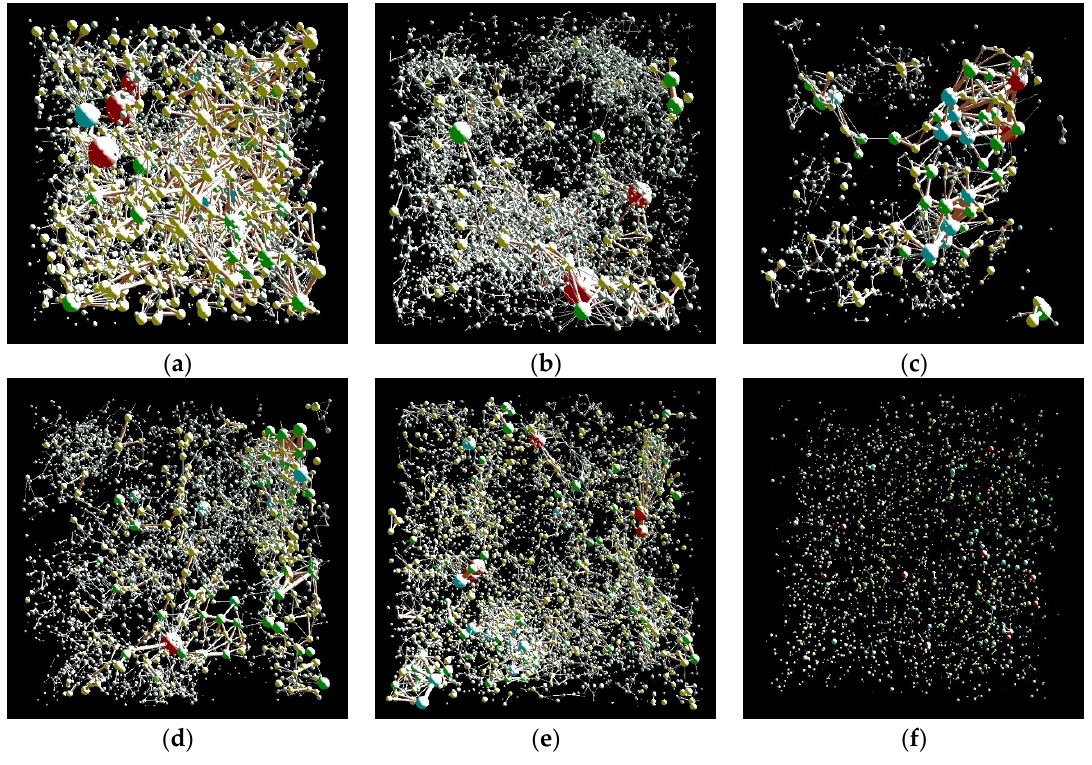
Figure 11. Pore network model of REV2 of different samples. ( a ) Carbonate rock A. ( b ) Carbonate Table 4. Statistical results of pore network of REV2 of tested samples.